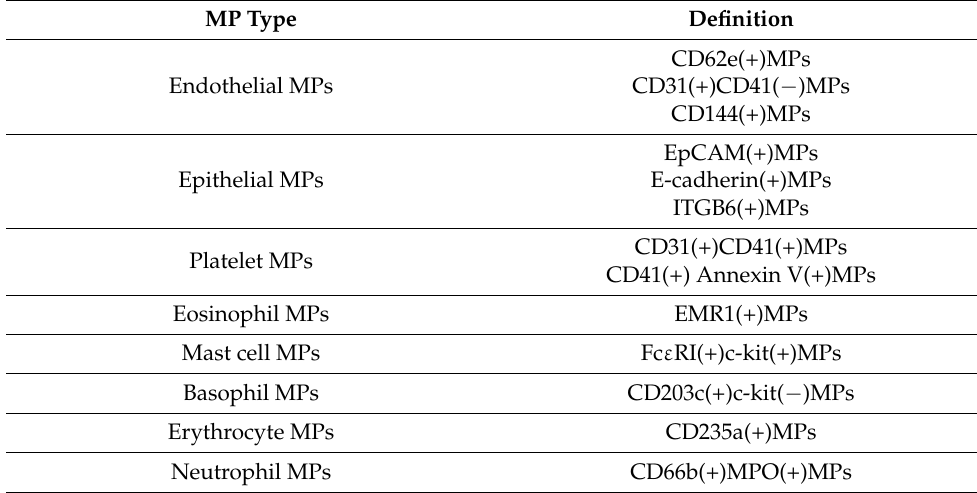
Table 2. MP subtypes detected in